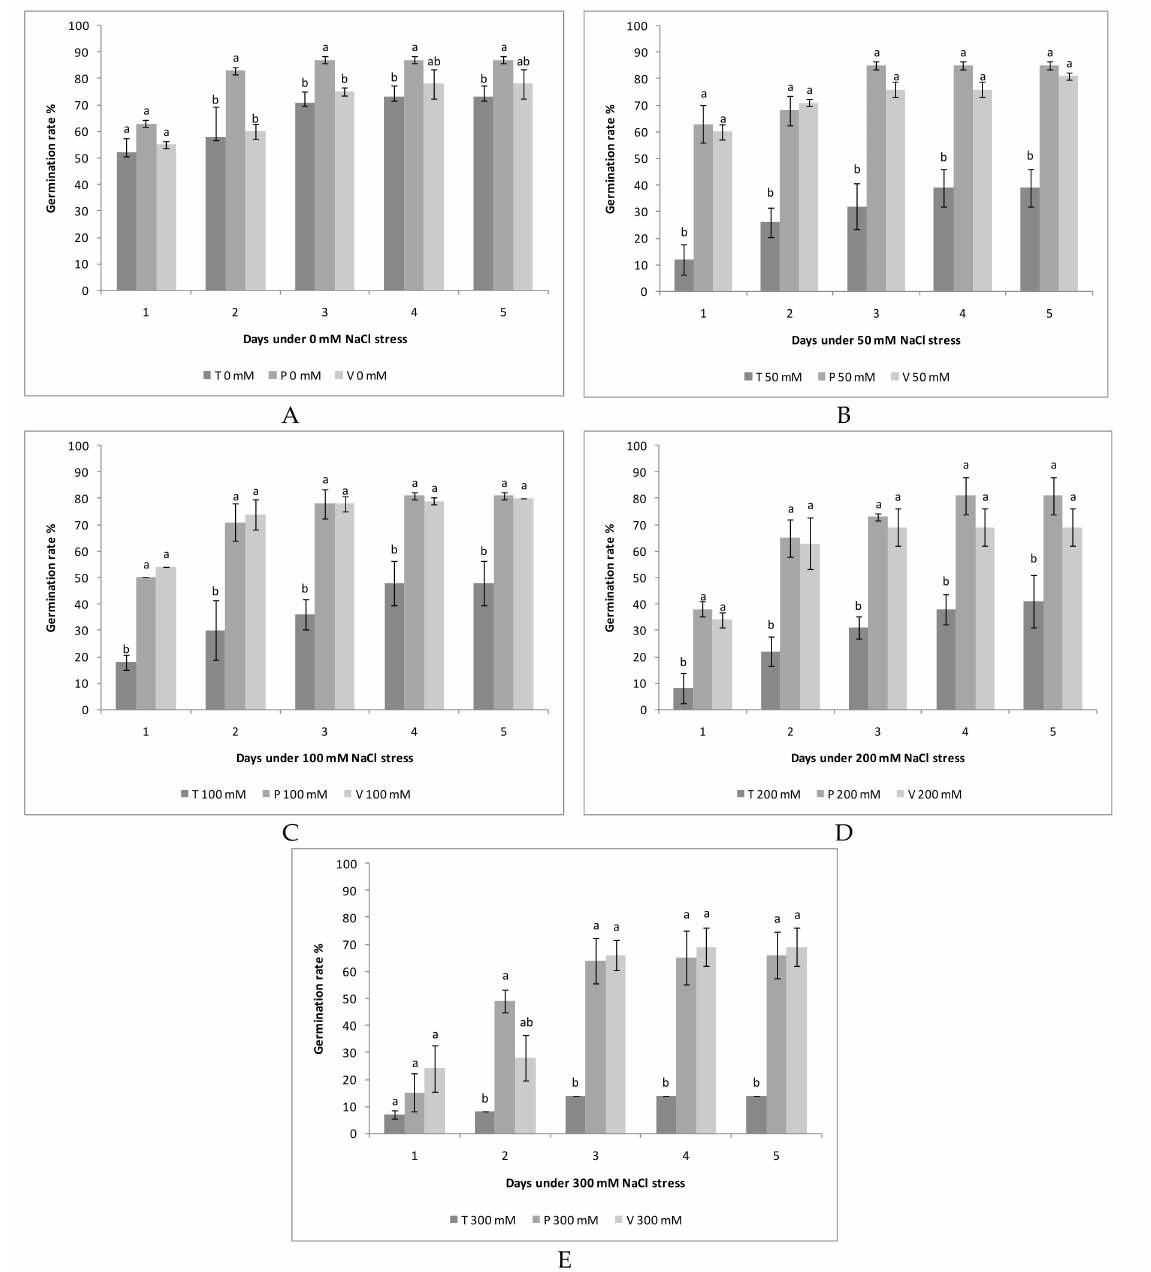
Figure 4. Comparisons between Titicaca (T), Puno (P) and Vikinga (V) cultivars under 0 mM NaCl ( A ), 50 mM NaCl ( B ), 100 mM NaCl ( C ), 200 mM NaCl ( D ), 300 mM NaCl ( E ) stresses. Di ff erent letter means significant di ff erences, according to Tukey test. Error bars indicate mean ±